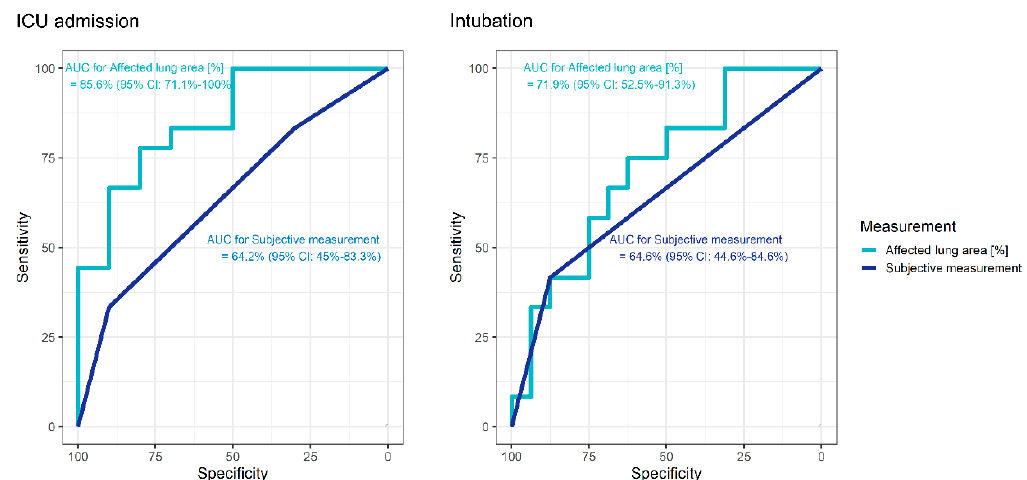
Figure 5. Receiver operating characteristic (ROC) curves to evaluate the diagnostic performance of